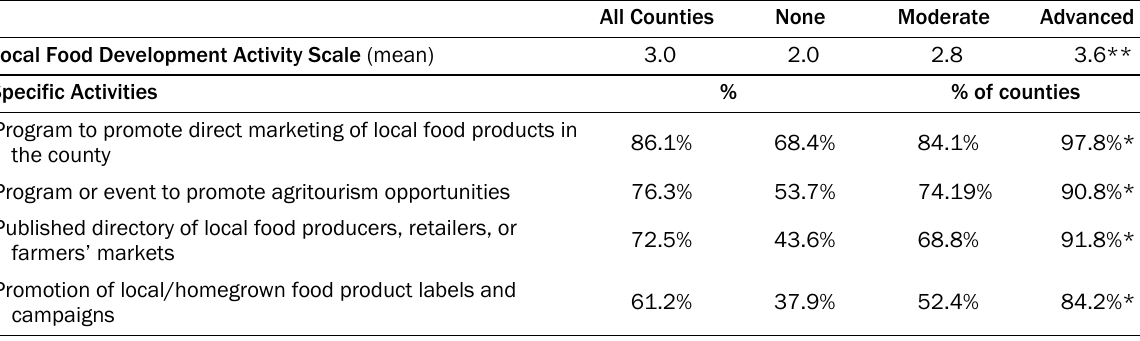
Table 4. Local Food System Development Activity by Level of Organization